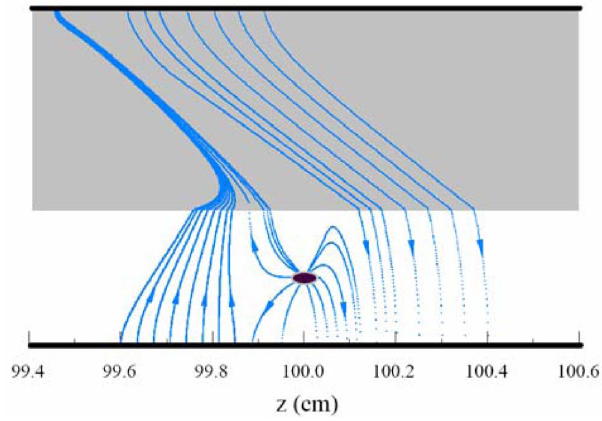
FIG. 11. (Color) Electric field force lines for 400 propagating and 400 decaying modes around a moving point bunch in a DLW structure. Parameters for the structure and the bunch are given in Fig. 9. Compared with Fig. 10 the essential difference is in that there are fields in front of the bunch and all force lines stop either on the bunch or on the conducting walls.